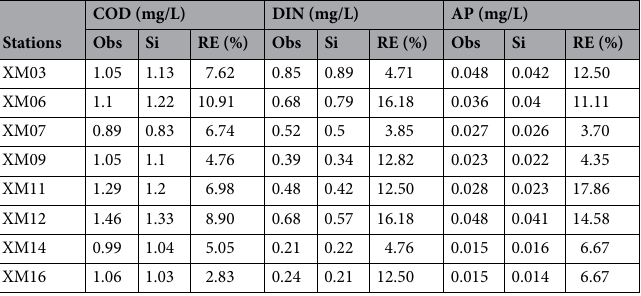
Table 5. Comparsion between observation (Obs.) and simulation (Si.) concentration of COD, DIN and AP.